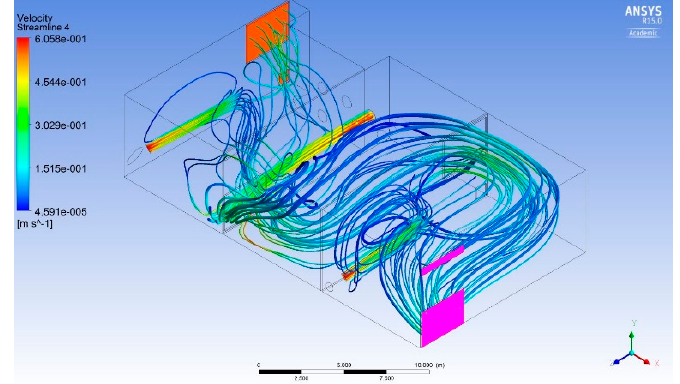
Figure 9. Isometric view of streamline path plot.